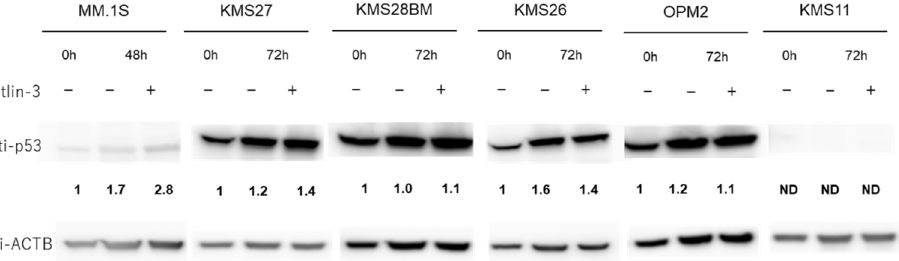
Figure 2. Changes in primary miR-34a (pri-miR-34a) and mature miR-34a/b expressions in response to MDM2 inhibitor nutlin-3 in six myeloma cell lines. ( A ) MM.1S was treated for 48 h with nutlin-3 at concentrations of 0 µM and 1 µM. ( B ) KMS27, ( C ) KMS28BM, ( D ) KMS26, ( E ) OPM2, and ( F ) KMS11 were treated for 72 h with nutlin-3 at 0 µM and 10 µM. Experiments were performed in triplicate. Error bars show the standard deviation (SD) across three experiments. Blue, with 0 µM nutlin-3; yellow, with 1 or 10 µM nutlin-3. ( G ) Western blot of p53 protein expression in response to nutlin-3 in myeloma cell lines. MM.1S was treated for 48 h with nutlin-3 at concentrations of 0 µM and 1 µM. KMS27, KMS28BM, KMS26, OPM2, and KMS11 were treated for 72 h with nutlin-3 at 0 µM and 10 µM. ND: Not detected.